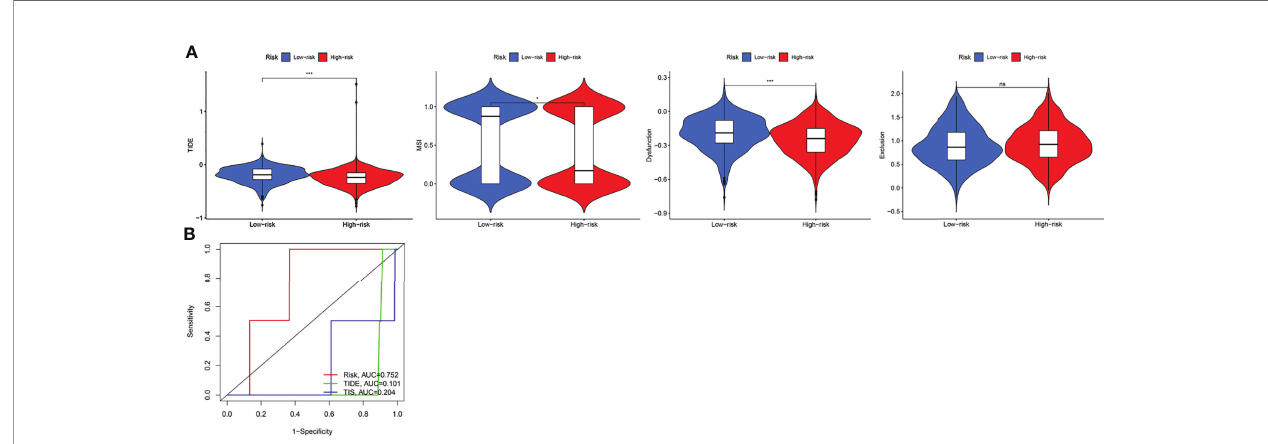
FIGURE 7 | The prognostic value of IRGPI in ICI therapy. (A) TIDE, MSI, and T-cell exclusion and dysfunction score in different IRGPI subgroups. The scores between the two IRGPI subgroups were compared through the Wilcoxon test (ns, not signi fi cant, * P < 0.05, *** P < 0.001). (B) ROC analysis of IRGPI, TIS, and TIDE on OS at 5-year follow-up in breast cancer